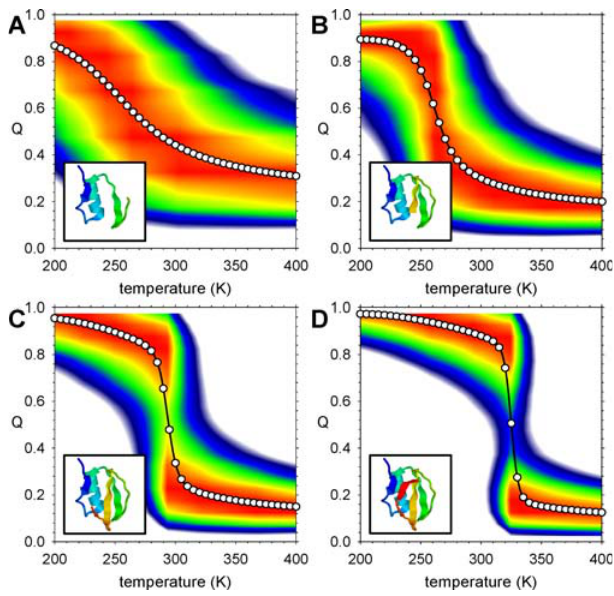
Figure 2. Folding Free Energy Surfaces for CI2 Fragments (A–D) Free energy surfaces for fragments comprising residues 1–40, 1– 50, 1–60, and 1–64 (full length), respectively. Free energy (G) is shown on a continuous color scale from 0 (red) to þ 5 kcal/mol (white); symbols show the mean value of Q in 5-K intervals. Cartoons in bottom-left corner of each panel indicate the ‘‘ native ’’ structure of each fragment generated using RasMol [94]. DOI: